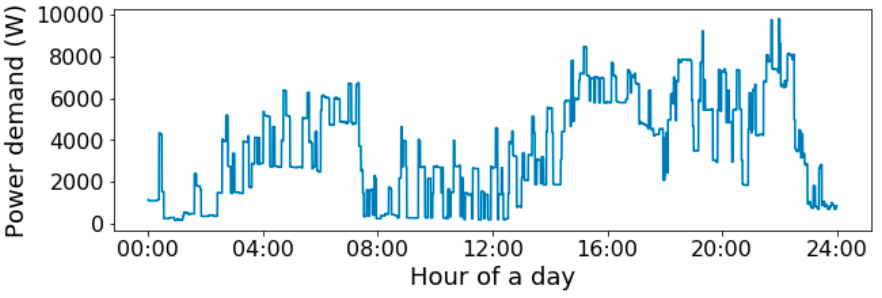
Figure 5. Power demand of a day.